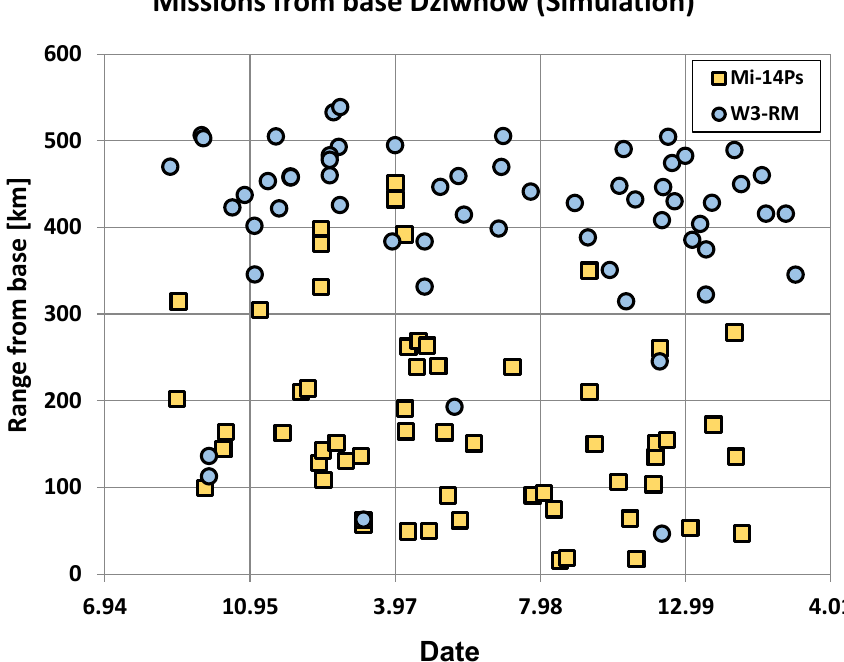
Figure 7. Range from base for simulated missions which started from Dziwnów base in years 1995–2001; W3-RM and Mi-13PS helicopters were used.